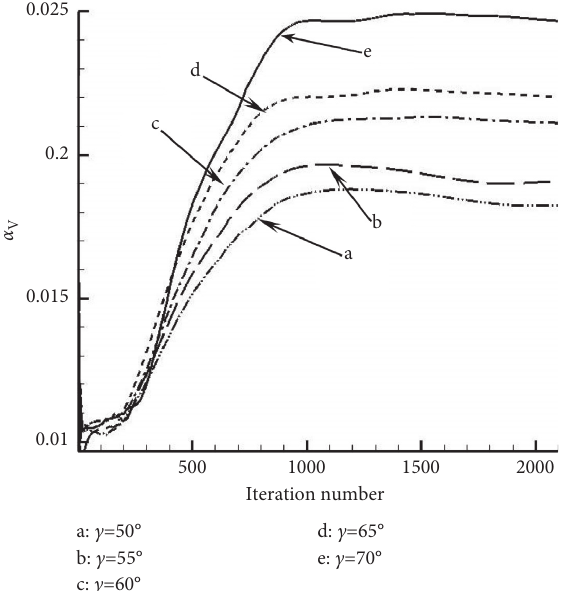
Figure 10: Curves of valve plate triangular throttling groove and its kidney shape hole α v with the change of c .